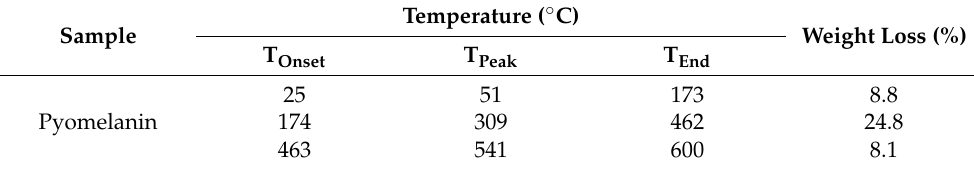
Table 1. Thermogravimetric properties of melanin compound from B. haynesii CamB6.